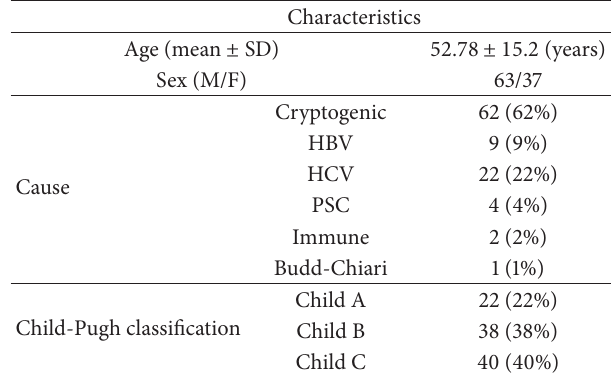
Table 2: Baseline data of study